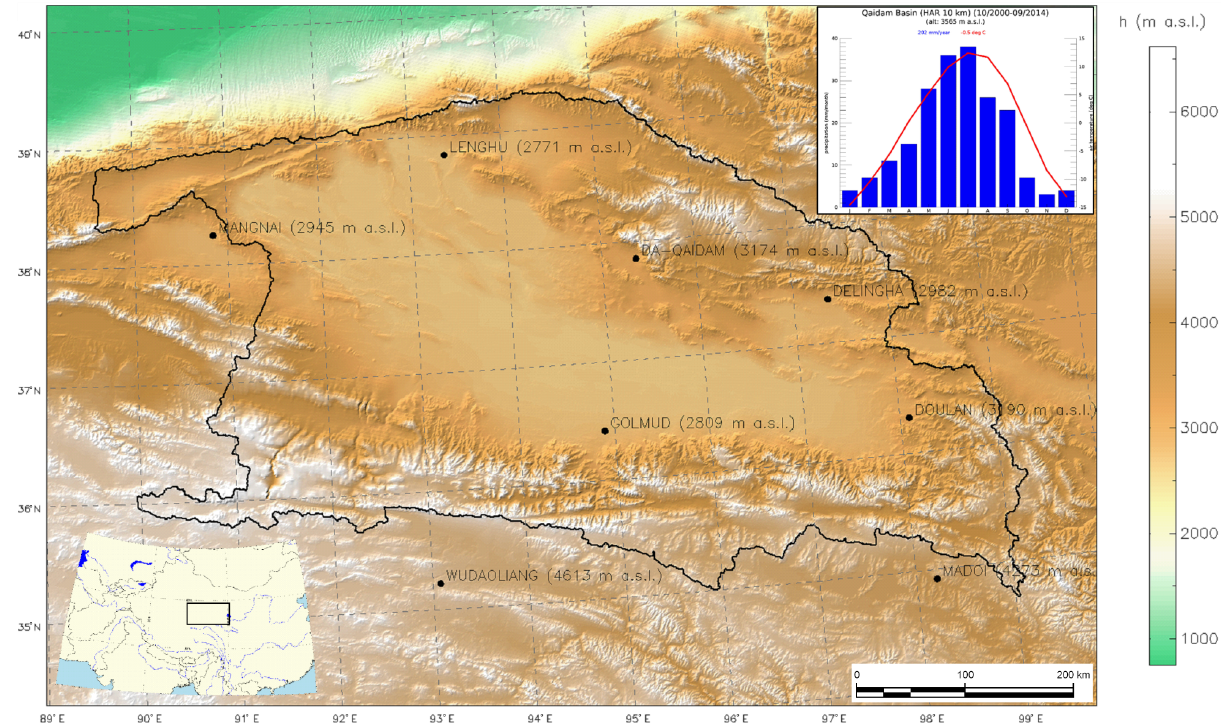
Figure 1. Overview of the Qaidam Basin (QB), including a spatially averaged climate diagram for the QB derived from the HAR 10km data set for the study period of 14 hydrological years (2001–2014). Black line: boundary of the QB (Lehner and Grill, 2013). Topographic shading is based on DEM data from the SRTM. Black dots indicate the locations of the eight GSOD stations within or nearby the